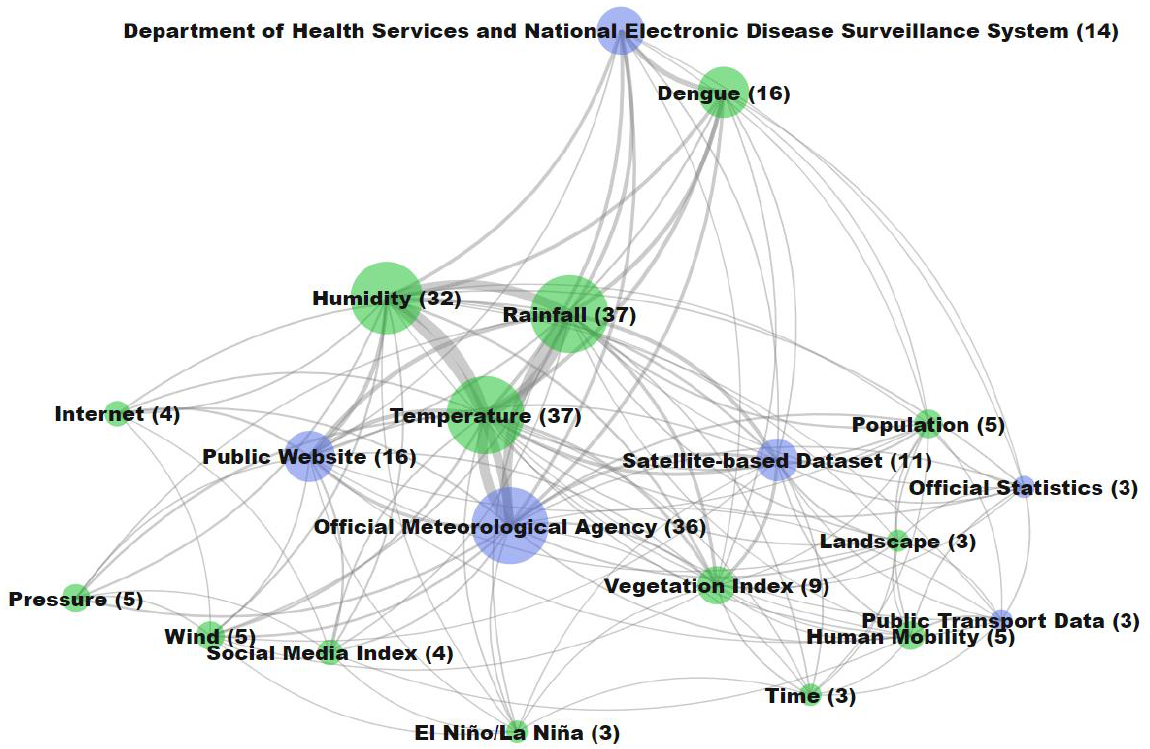
Figure 4. The co-occurrence map of predominate dengue risk predictors and data sources identified from selected articles. We set the minimum number of keyword occurrences to 2 to map all keywords. The keywords in green indicate the predominant predictors, and the keywords in purple indicate the predominant data sources. The number in brackets indicates the number of a keyword appearing. A keyword is associated with each node in the co-occurrence map, with each edge representing a co-occurrence link between two keywords.